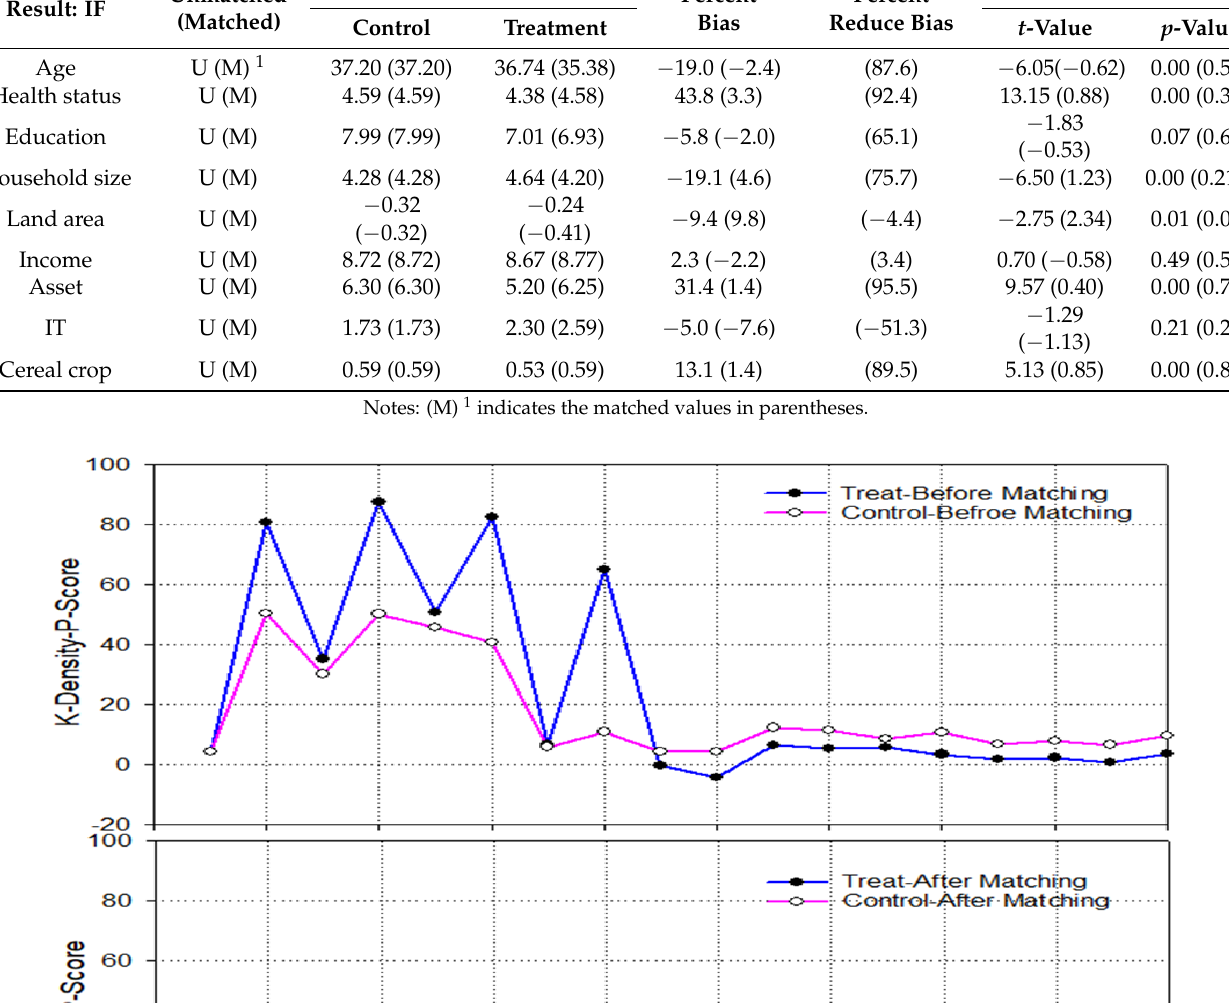
Table 5. Propensity score matches balance test outcomes.